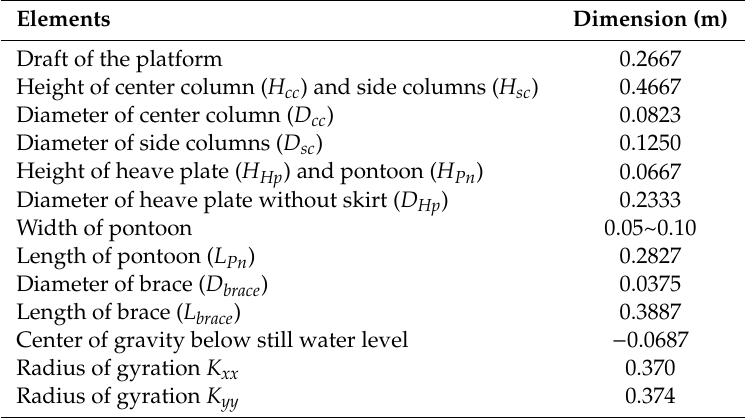
Table 1. Dimension and hydrostatic properties of the 1:60 scale semi-submersible